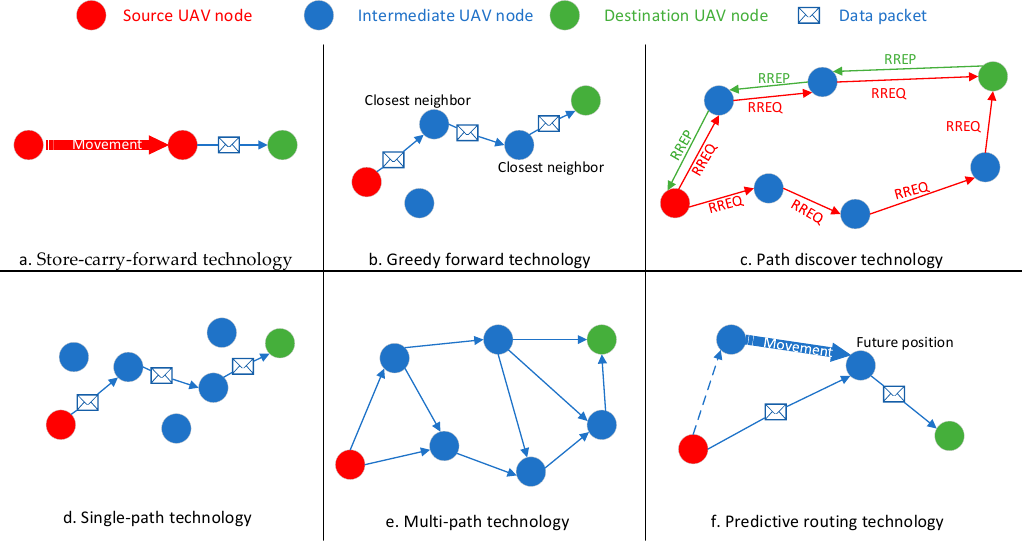
Figure 6. The rationales for common routing technologies of UAV ad hoc network. ( a ) Store-carry- forward technology, ( b ) Greedy forward technology, ( c ) Path discover technology, ( d ) Single-path